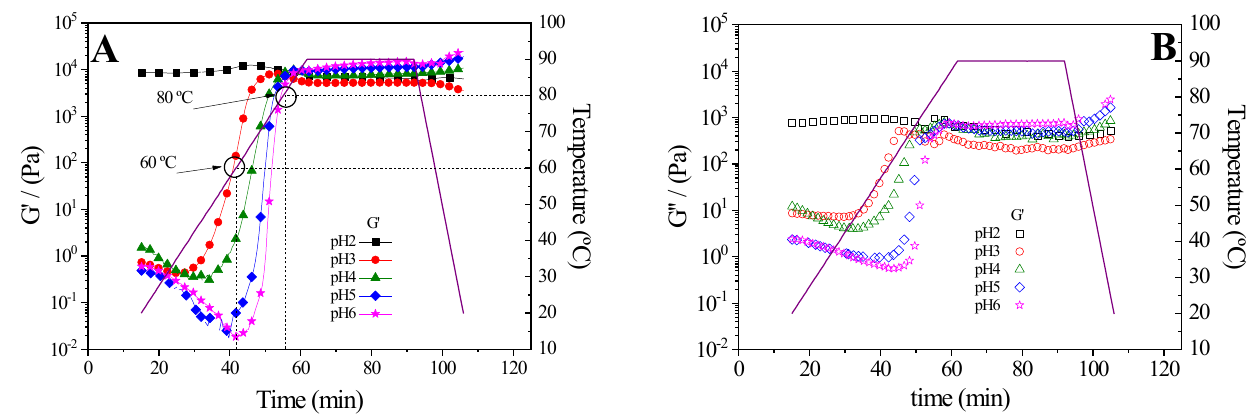
Figure 2. Evolution of storage modulus ( A ) and loss modulus ( B ) with temperature for the egg yolk acidulated with citric acid as a function of pH (2, 3, 4, 5, and 6).